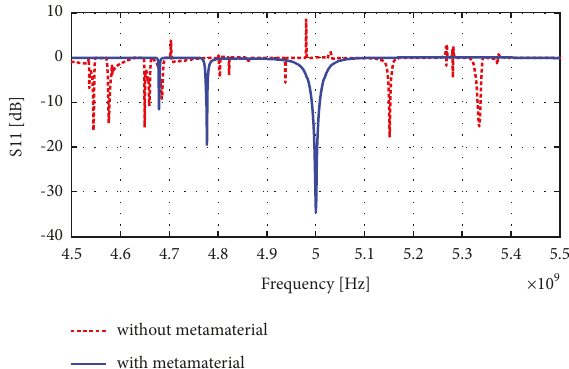
Figure 13: Comparison of return loss of the proposed antenna with and without